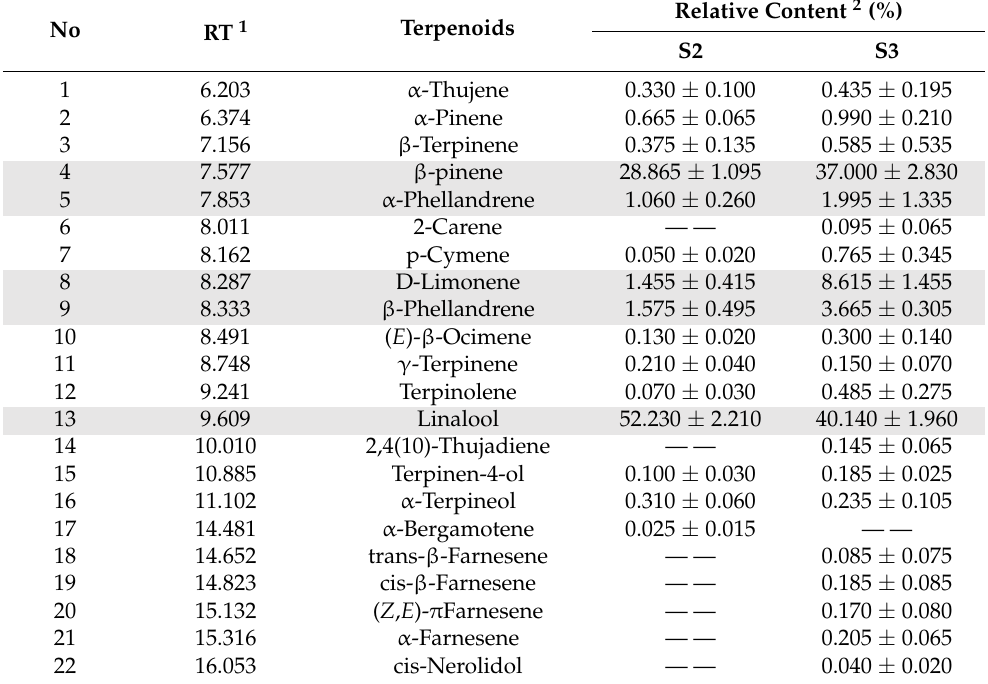
1 Retention time (RT) in min. 2 Relative peak area expressed as percentage of the peak area of corresponding compound over the total peak areas of all identified volatiles. — —, not detected. The relative contents of five major terpenoids were labeled in light